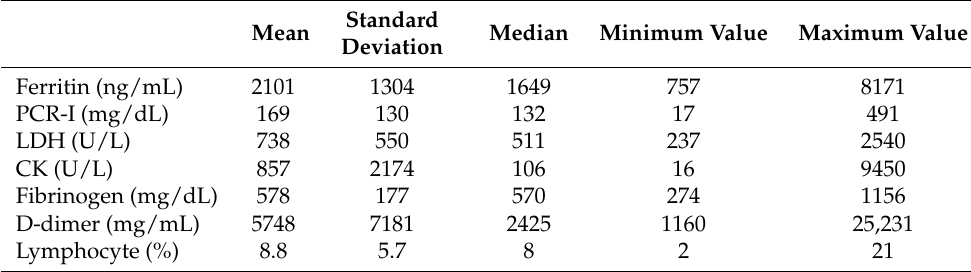
Table 5. Descriptive statistics for the patients’ diagnostic tests.